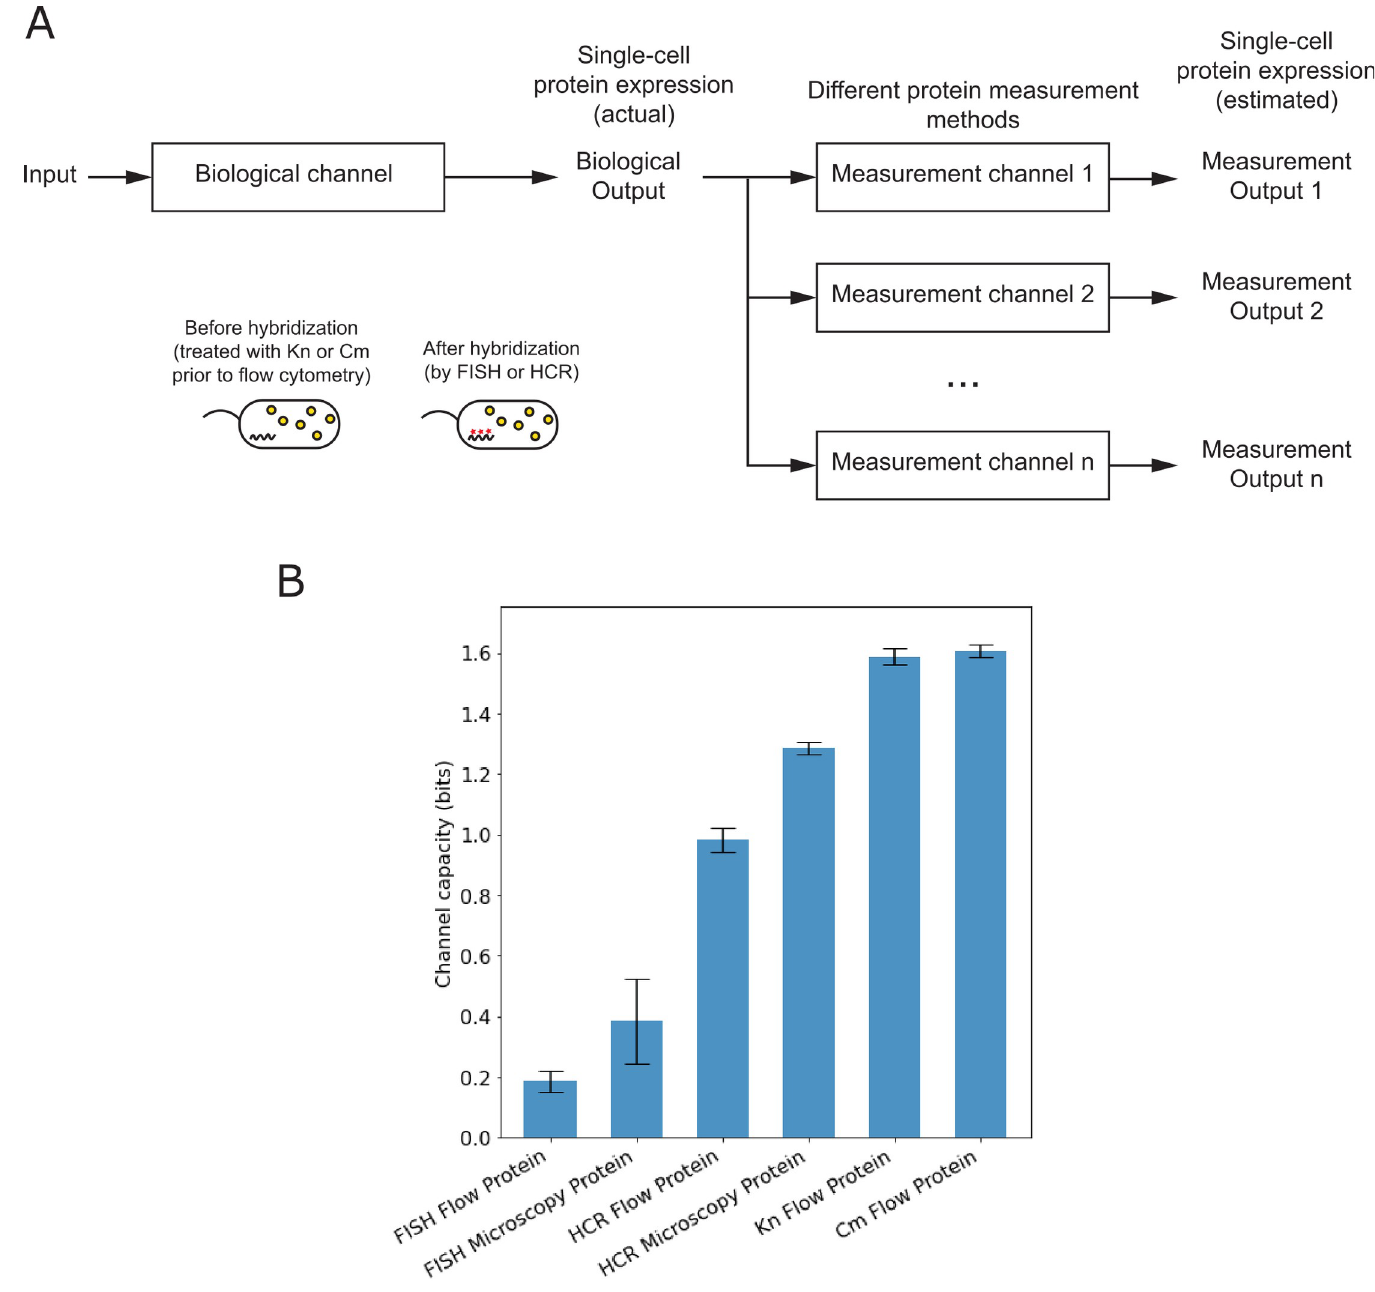
Fig 3. Single-cell measurement quality of fluorescent protein expression, in bits. (A) Different single-cell methods of measuring fluorescent protein use different steps for sample preparation and signal detection. Different antibiotic treatments (kanamycin, Kn; chloramphenicol, Cm) can be used to halt translation prior to fluorescent protein measurement by flow cytometry. Fluorescent protein can also be detected in cells following RNA-labeling methods such as fluorescence in situ hybridization (FISH) or hybridization chain reaction (HCR) (inset). Examples of signal detection include microscopy and flow cytometry. When different single-cell methods are used to analyze the same biological output, the channel capacity between input and different measurement outputs can be used to compare single-cell measurement quality of fluorescent protein expression, in bits. (B) Channel capacities of different single-cell methods of estimating fluorescent protein expression from the same biological channel (mean ± standard deviation of three biological